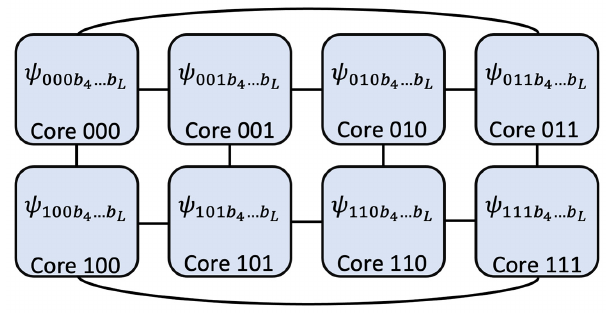
FIG. 1. The distribution of the many-body wave function over TPU cores. There are eight TPU cores depicted ( N g = 3), labeled by the binary strings 000, 001, . . . , 111. On each core, a branch of the full wave function is stored, where the state of the global qubits is fixed according to the TPU core. Lines between TPU cores indicate the toroidal pattern of intercore